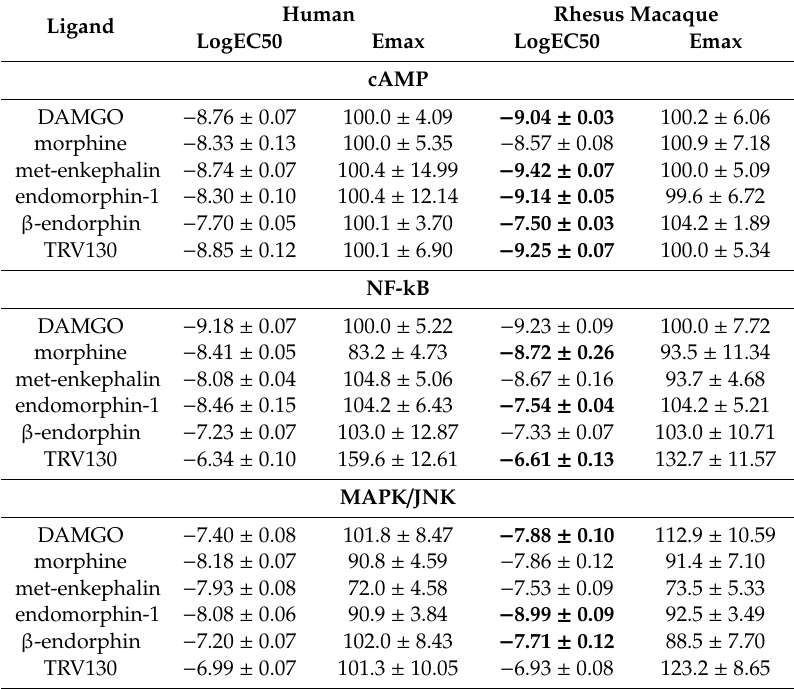
Table 1. Summary of ligand potencies and e ffi cacies in human and rhesus macaque MORs. Human Rhesus Macaque Ligand LogEC50 Emax LogEC50 Emax cAMP